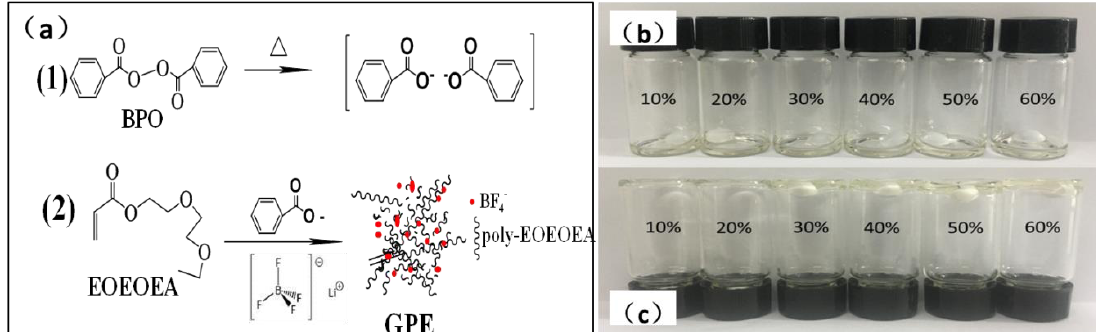
Figure 3. ( a ) The polymerization of EOEOEA initiated by BPO; precursor electrolytes with different contents of EOEOEA before ( b ) and after ( c ) heating.